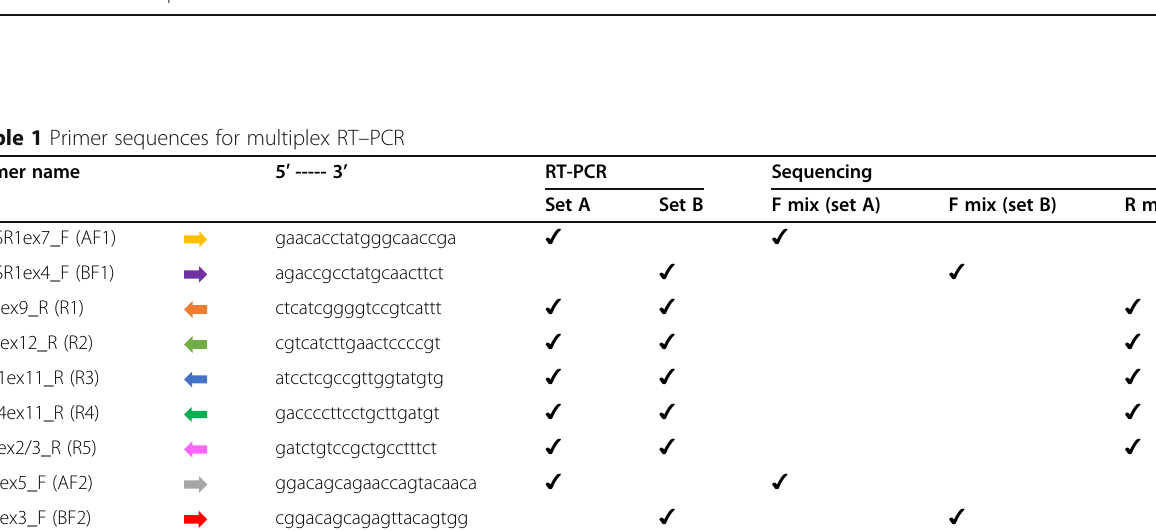
Fig. 1 Fusion transcript variants of EWS/FUS-ETS . Previously described fusion transcripts are indicated. The arrows indicate the primer position listed in Table 1. ND represents “ cannot be detected ”